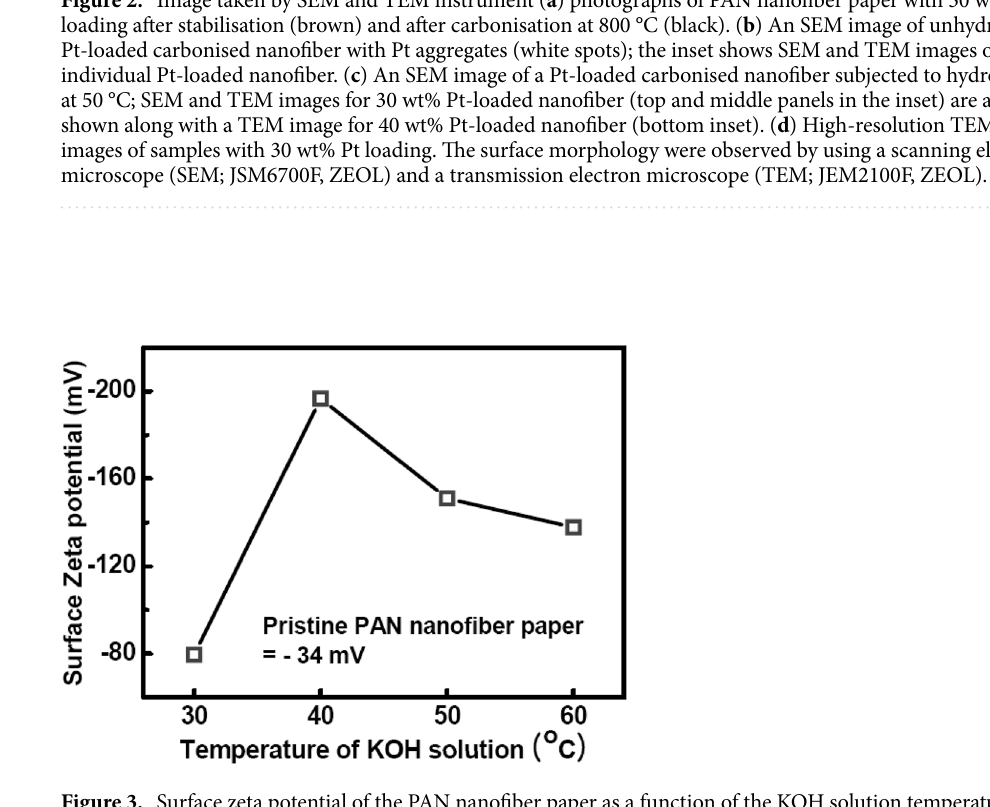
Figure 3. Surface zeta potential of the PAN nanofiber paper as a function of the KOH solution